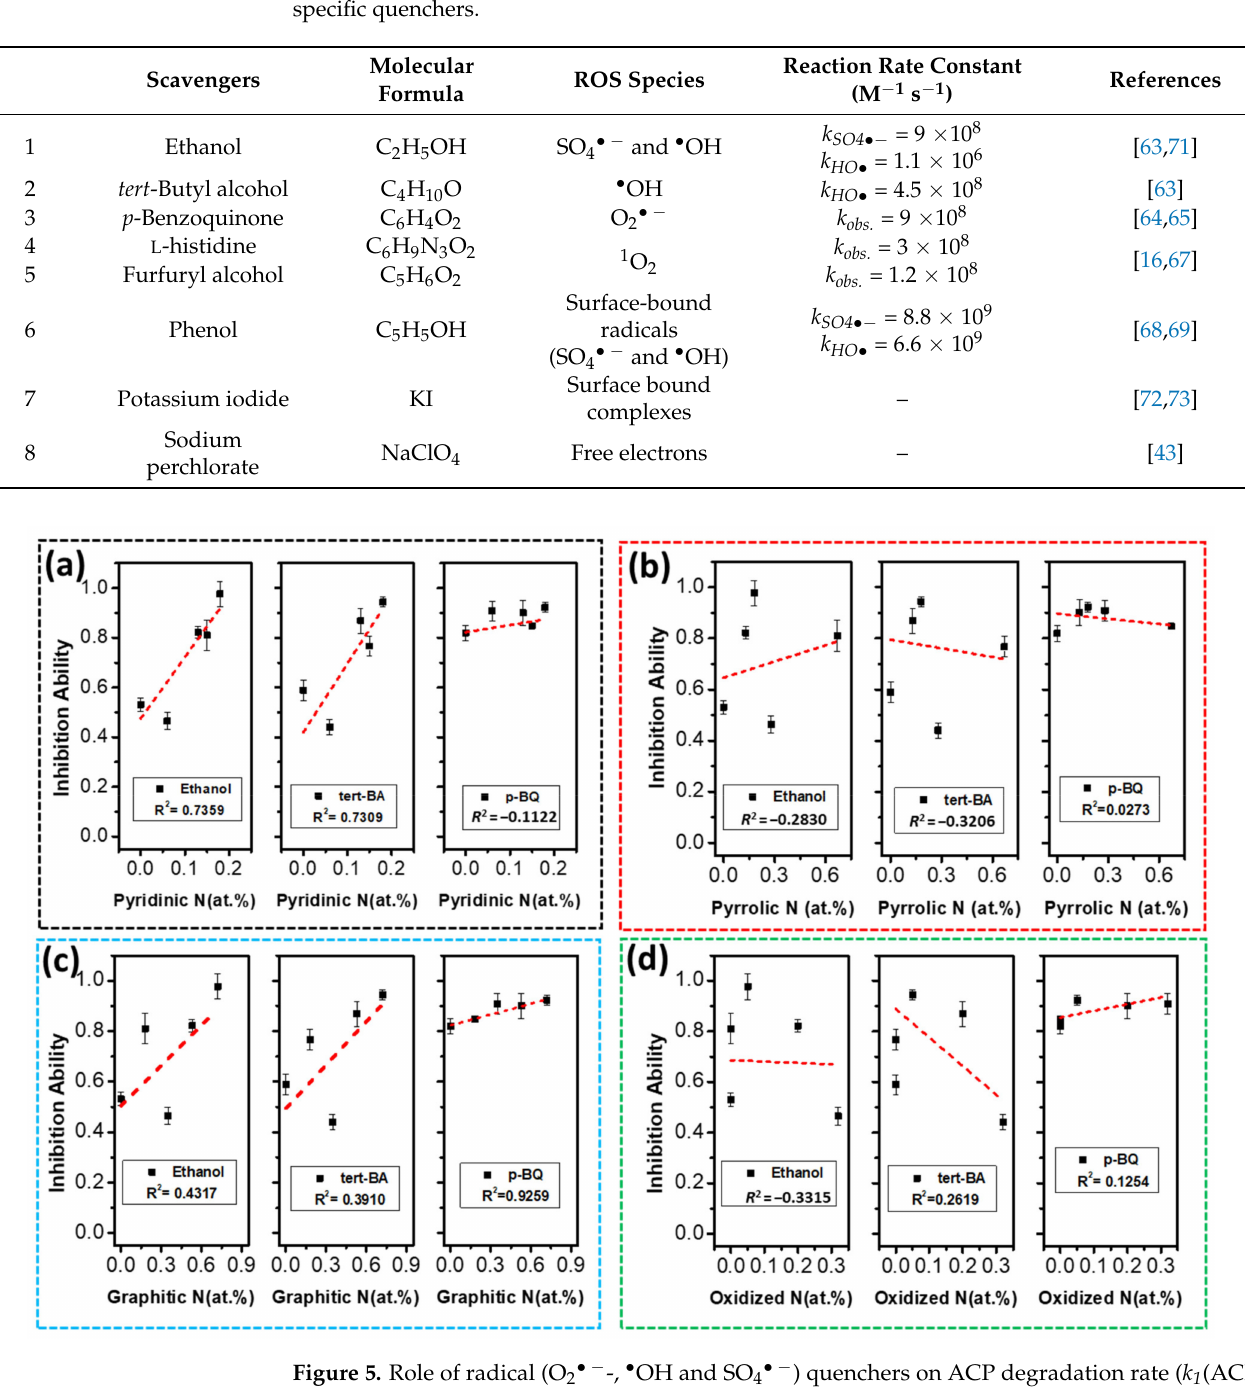
Figure 5. Role of radical (O 2 • − -, • OH and SO 4 • − ) quenchers on ACP degradation rate ( k 1 (ACP)). Correlation between k 1 (ACP) and pyridinic N ( a ), k 1 (ACP) and pyrrolic N ( b ), k 1 (ACP) and graphitic N ( c ), and k 1 (ACP) and oxidized N ( d ). Quenching studies were carried out at C ACP = 10 mg L − 1 , C Catalyst = 100 mg L − 1 , C PMS = 0.5 mM, C Ethanol or C tert-BA = 500 mM, C p-BQ = 50